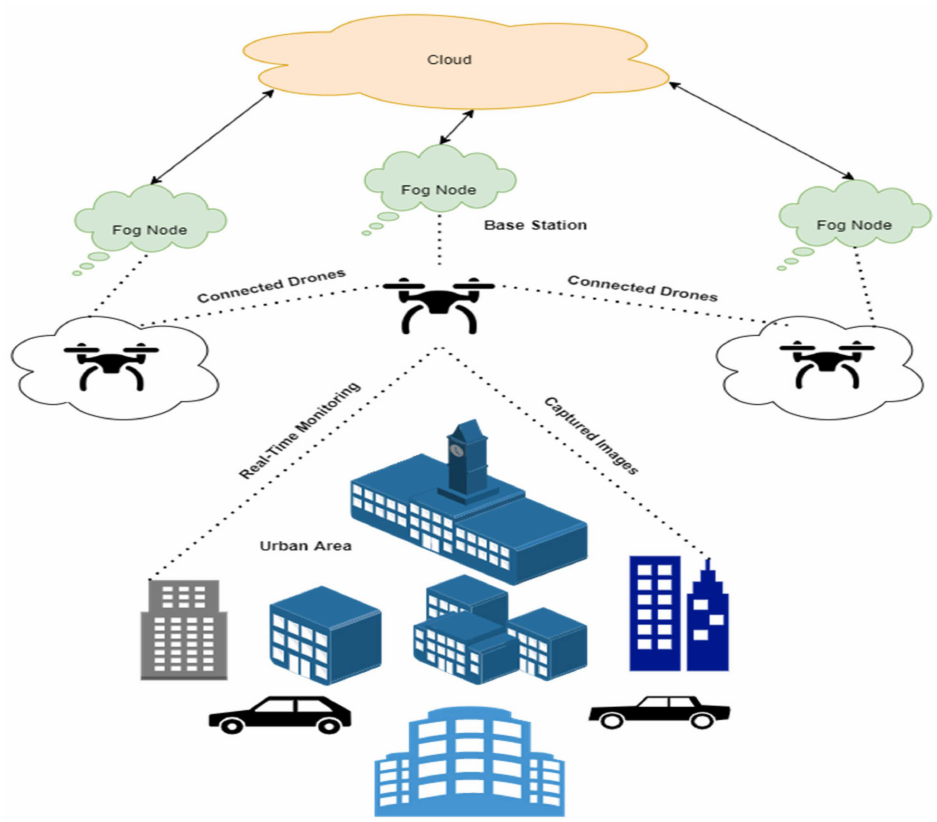
Figure 2. Current Scenario of Fog-Cloud Node Data Management and